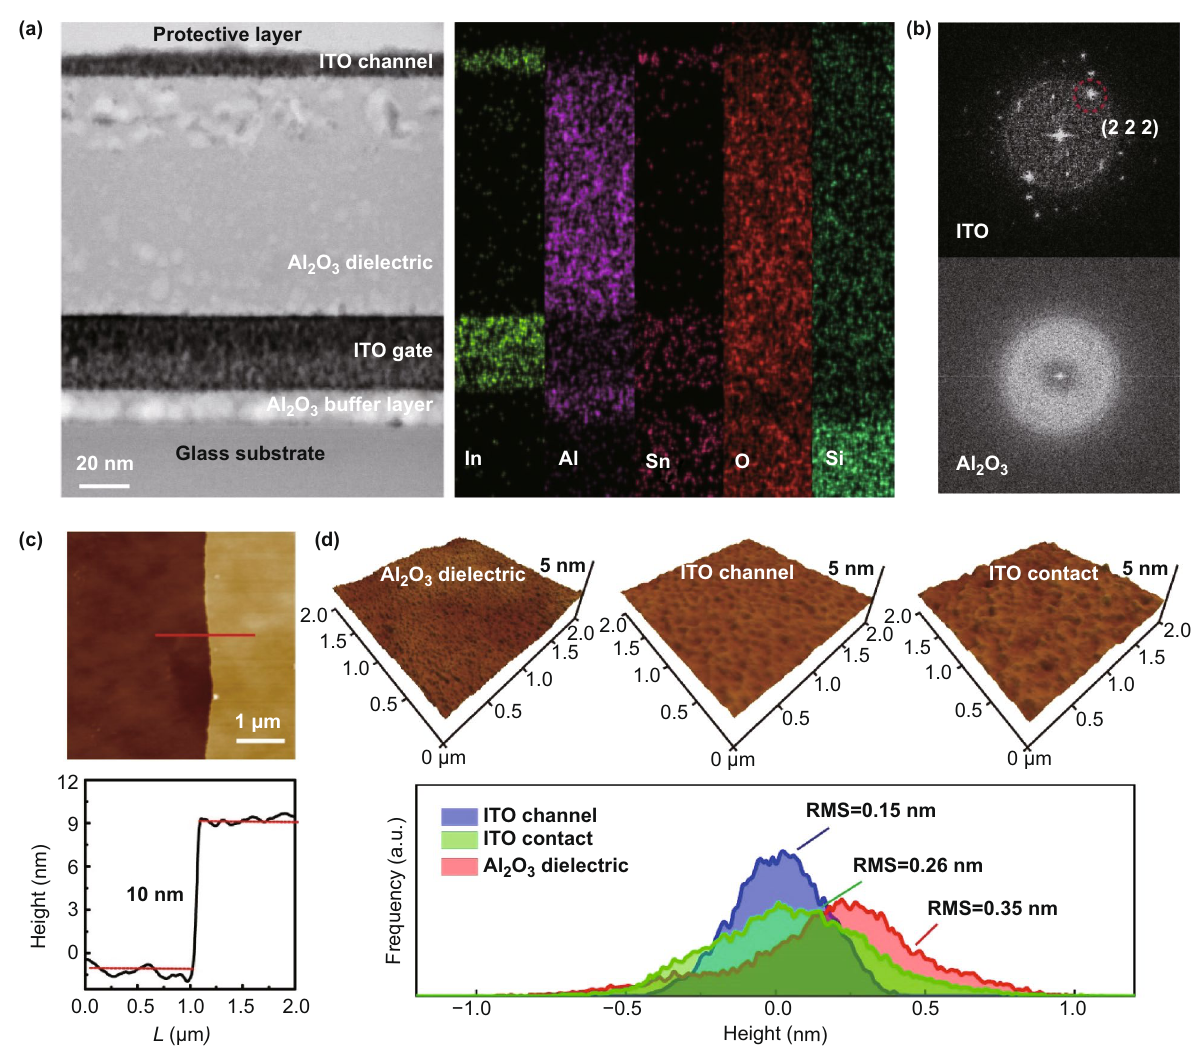
Fig. 3 Material characterization of inkjet-printed metal oxide films. a Cross-sectional TEM image (left) and corresponding EDS mapping (right) of elements indium (In), aluminum (Al), tin (Sn), oxygen (O), and silicon (Si). b FFT patterns obtained from the selected areas of the ITO and Al 2 O 3 layers. ITO exhibits nanocrystalline and Al 2 O 3 holds amorphous structures, and the lattice spacing of 0.29 nm corresponds to the (2 2 2) crystal plane of ITO. c AFM image and height profile of printed ITO channel film, showing an ultrathin thickness of ~ 10 nm. d AFM images showing the surface morphology (top) and height distributions (bottom) of Al 2 O 3 dielectric, ITO channel, and ITO contacts. The RMS values of ITO contact and Al 2 O 3 films are 0.26 and 0.35 nm, respectively. And ITO channel exhibits a narrower height distribution with RMS of only 0.15